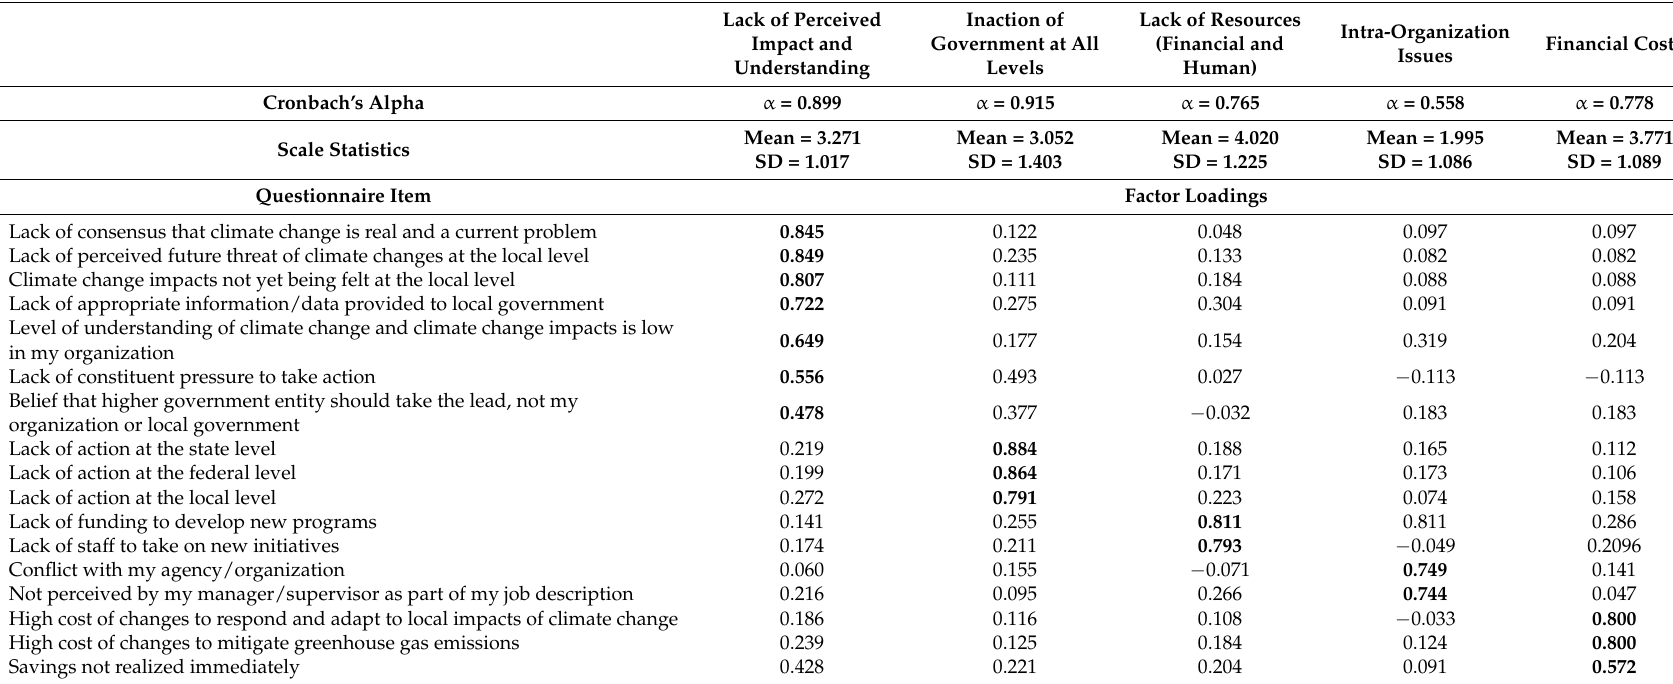
Table 2. Factor analysis results for climate action “Barriers” 1 including factor loadings, Cronbach’s alpha, and scale mean and standard deviation.